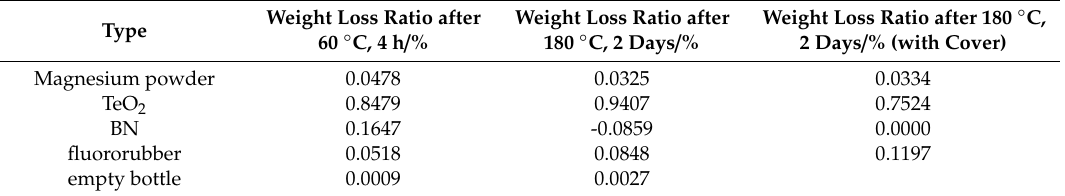
Table 2. Weight loss ratio of the components of the Mg / TeO 2 ignition composition.